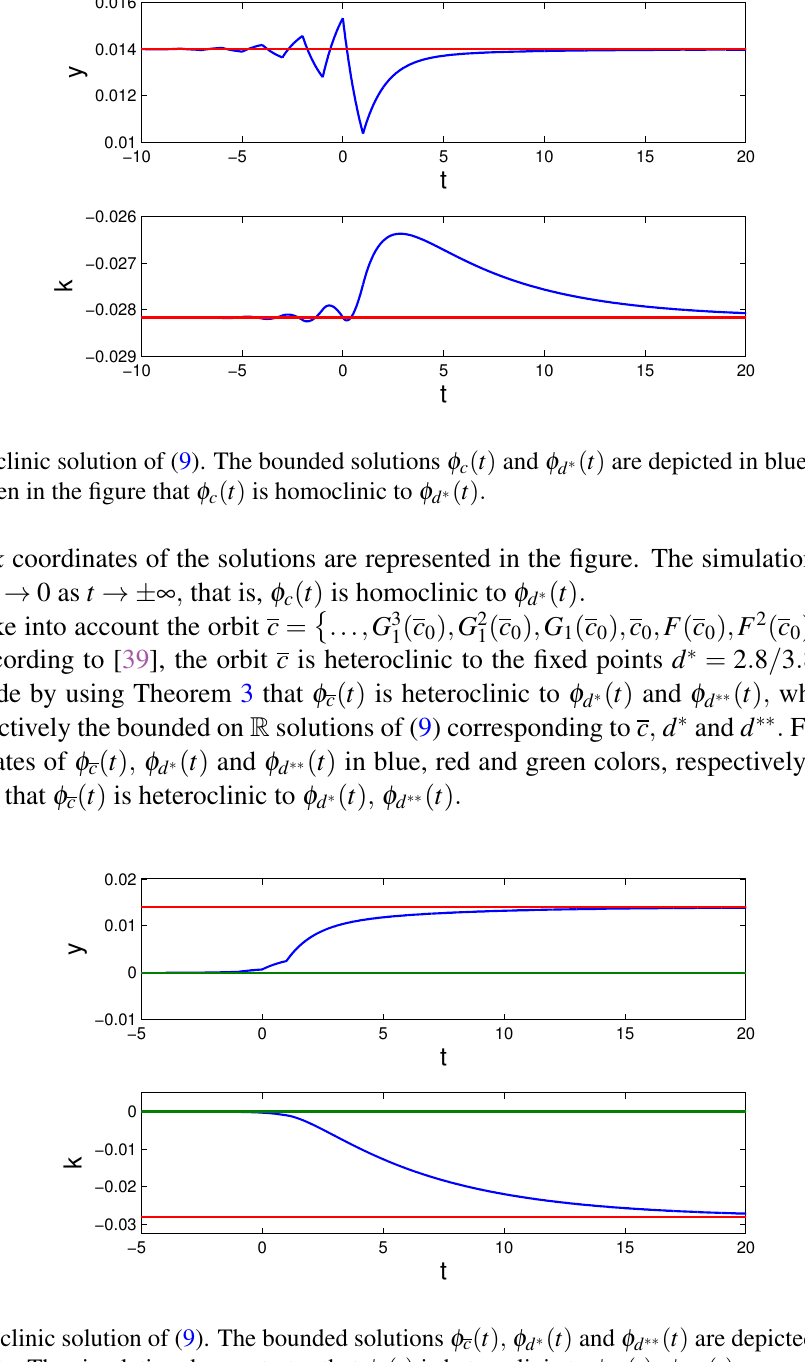
Fig. 3 The heteroclinic solution of (9). The bounded solutions φ c ( t ) , φ d ∗ ( t ) and φ d ∗∗ ( t ) are depicted in blue, red and green colors, respectively. The simulation demonstrates that φ c ( t ) is heteroclinic to φ d ∗ ( t ) , φ d ∗∗ ( t )